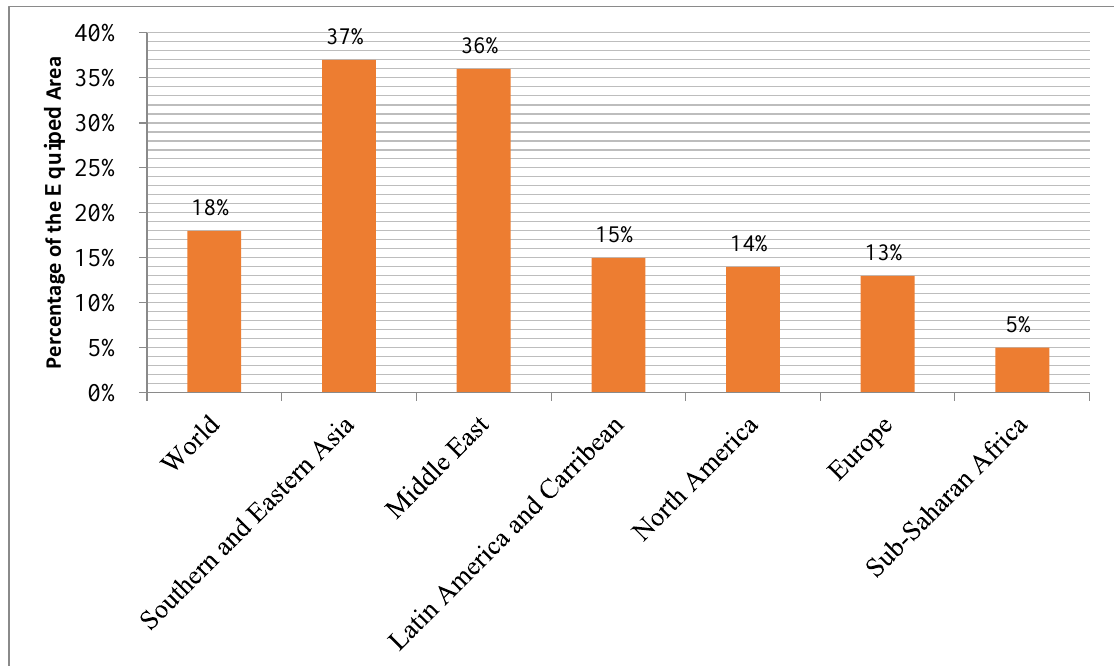
Figure 10. The equipped area under irrigation by region. Source: Domenech, 2010.